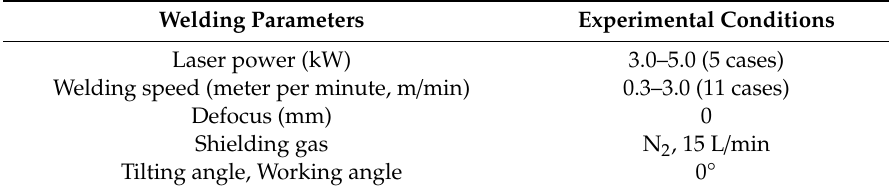
Table 3. Experimental conditions of laser Bead on Plate